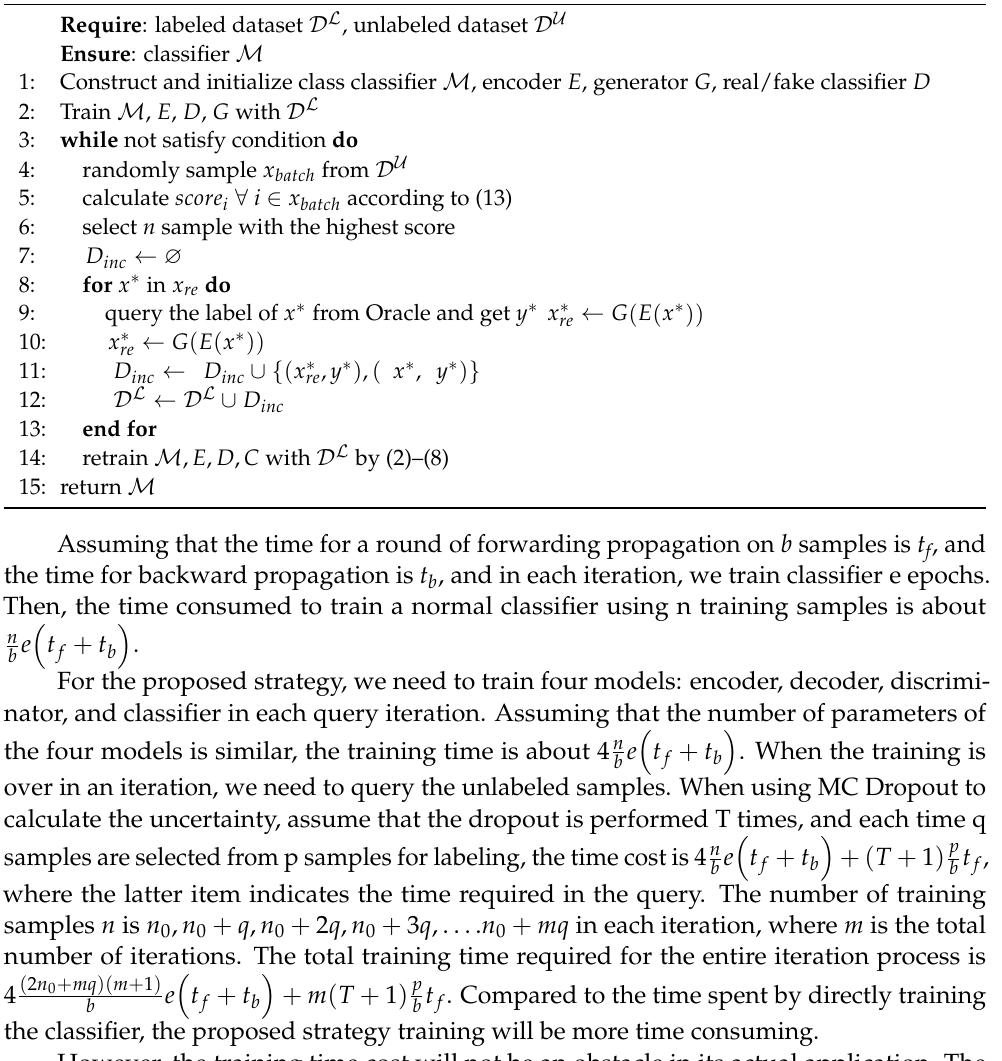
Algorithm 1. Procedure of the proposed